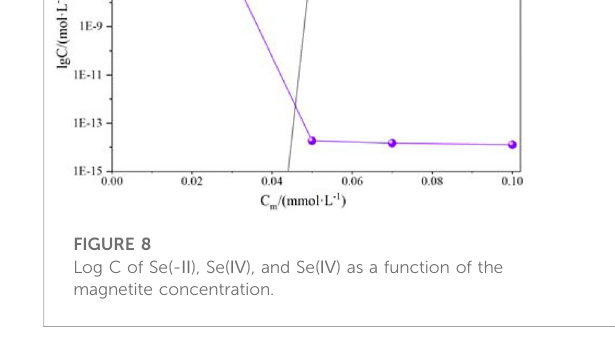
FIGURE 6 Pourbaix diagrams produced by PhreePlot (Parkhurst and Appelo, 1999; PhreePlot Guide, 2020) using the THERMOCHIMIE- TDB 10a database from ANDRA/RWM of France (re-plotted by handwork). The following conditions have been used for groundwater and [Se] tot = 10 − 4 mol L − 1 . The upper and lower boundaries are the stable boundaries of H 2 O.